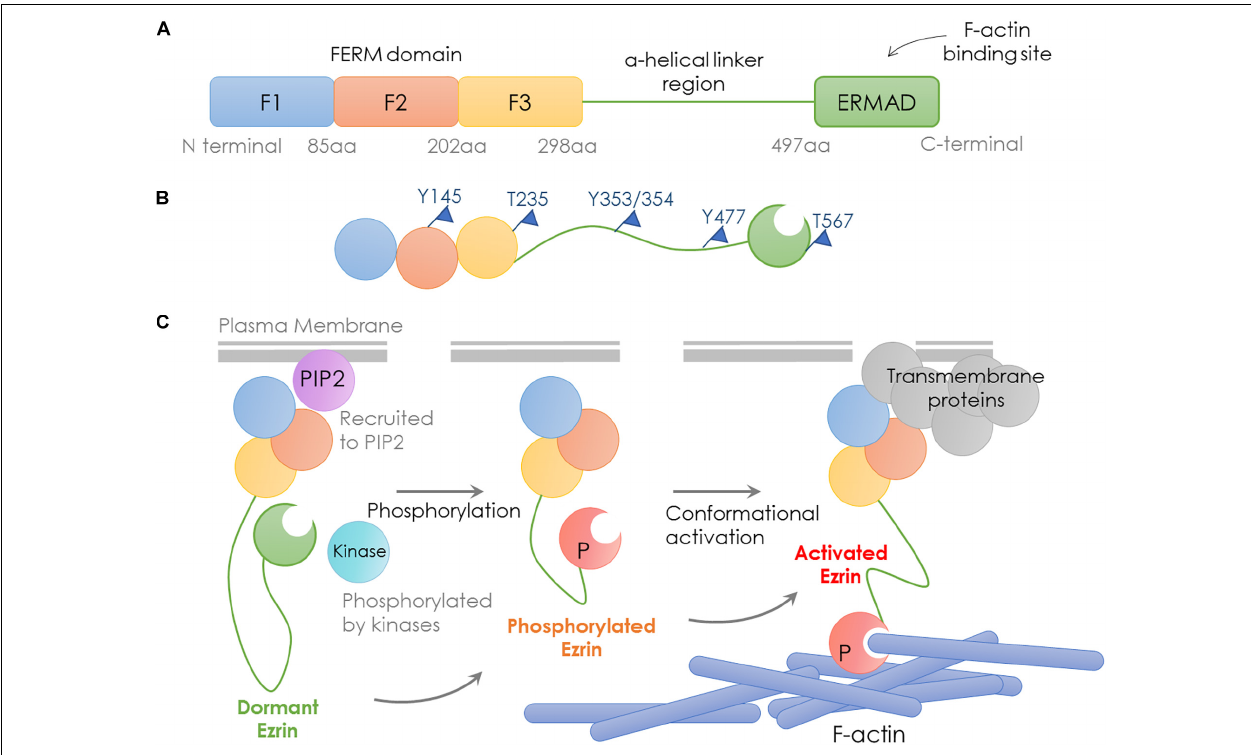
FIGURE 1 | Structure and activation process of Ezrin. Schematic representation of domain structure, activation states and binding partners of Ezrin protein. (A) Domain structure of Ezrin includes the N-terminal FERM domain (band 4.1 protein, Ezrin, Radixin, Moesin), the central α -helical linker region and the C-terminal ERM-associated domain (C-ERMAD, green). The FERM domain comprises three subdomains, F1, F2, and F3 (blue, red, and yellow) and C-ERMAD contains the F-actin-binding site. (B) The putative open state of Ezrin protein and its phosphorylation sites. (C) Various states and binding partners of Ezrin protein. (1) Ezrin is phosphorylated at several sites (e.g., T567 in Ezrin, T564 in Radixin and T558 in Moesin); (2) Ezrin is recruited to PIP2; (3) Activated Ezrin monomer (or head-to-tail dimer) binds with F-actin; (4) Ezrin binds with transmembrane receptors such as CD43/44, ICAM1/2 and NHE-1. TABLE 1 | Ezrin phosphorylation sites and kinases. Phosphorylation Kinases sites